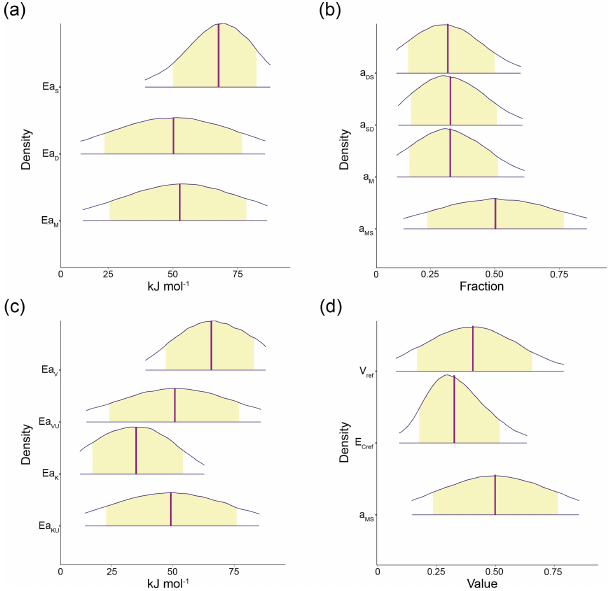
Figure 4. The 95% probability density credible areas for model parameters corresponding to prewarming steady- state SOC = 100mgCg − 1 soil, DOC = 0.2mgCg − 1 soil, MIC = 2mgCg − 1 soil, and (for AWB) ENZ = 0.1mgCg − 1 soil. Yellow shaded regions represent the 80% credible areas and vertical purple lines indicate distribution mean. (a) CON activation energy parameters Ea S , Ea D , and Ea M ; (b) CON C pool partition fraction parameters a DS , a SD , a M , and a MS ; (c) AWB activation energy parameters Ea V , Ea VU , Ea K , and Ea KU ; (d) AWB param- eters V ref , E C , and a MS . V ref is the SOC V max at the reference ref temperature 283.15K; E C is the carbon use efficiency fraction ref at the reference temperature; and, like its CON counterpart, the AWB a MS parameter is the fraction parameter representing the proportion of dead microbial biomass C transferred to the SOC pool. Parameter units are displayed in Table S1. Credible areas for AWB parameters V U and m t are shown in Fig. S2 because of ref differing horizontal axes